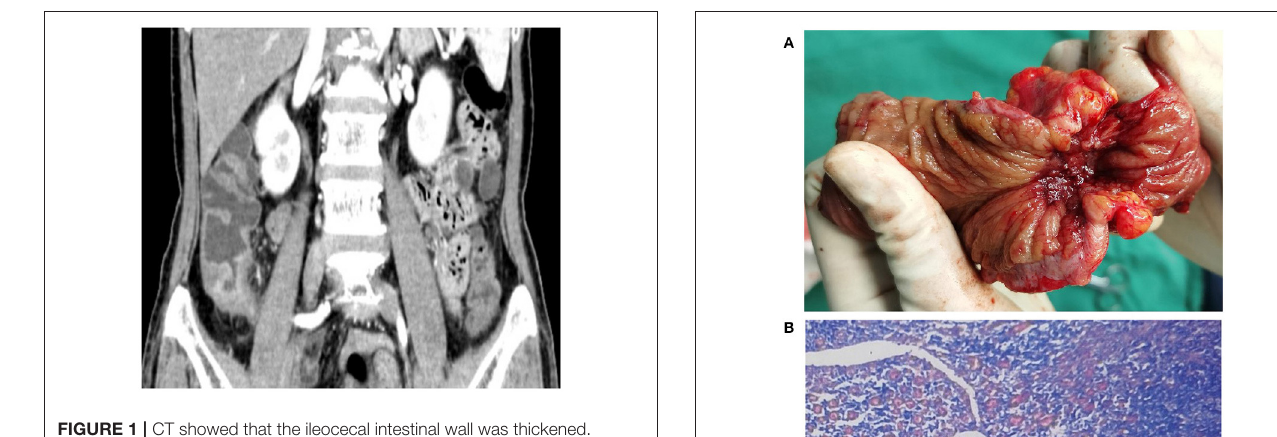
FIGURE 1 | CT showed that the ileocecal intestinal wall was thickened.